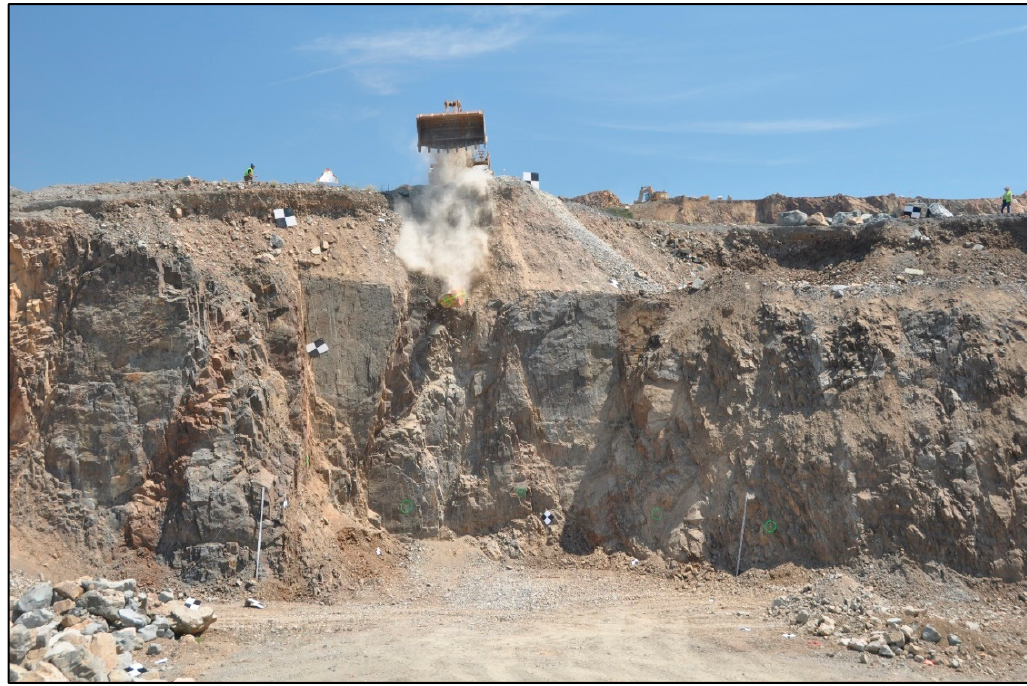
Figure 3. Picture of a block falling down in test site 3.